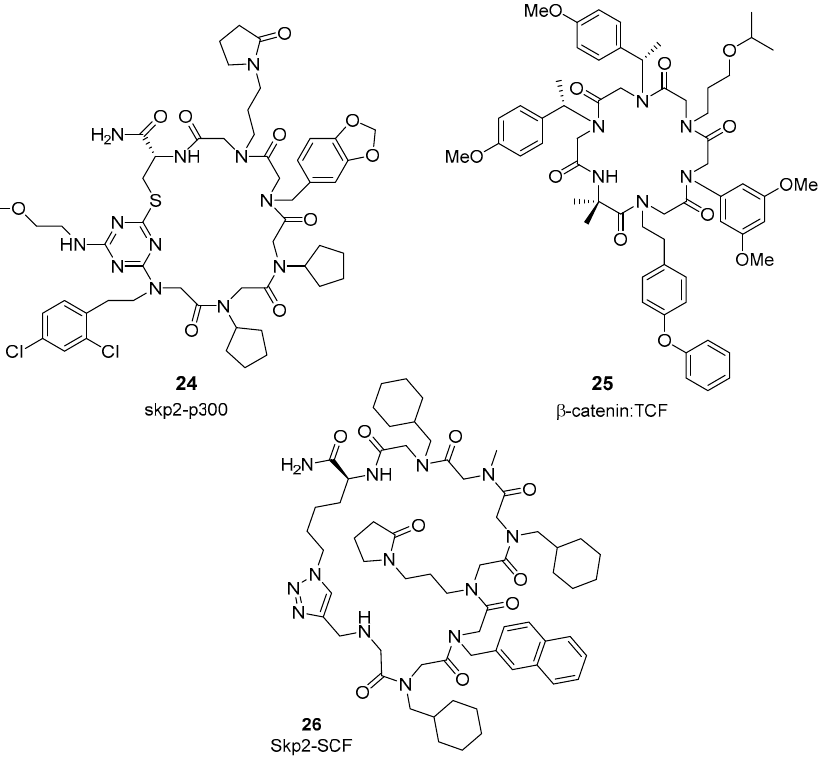
Figure 7. Peptoid-based inhibitors of PPIs.